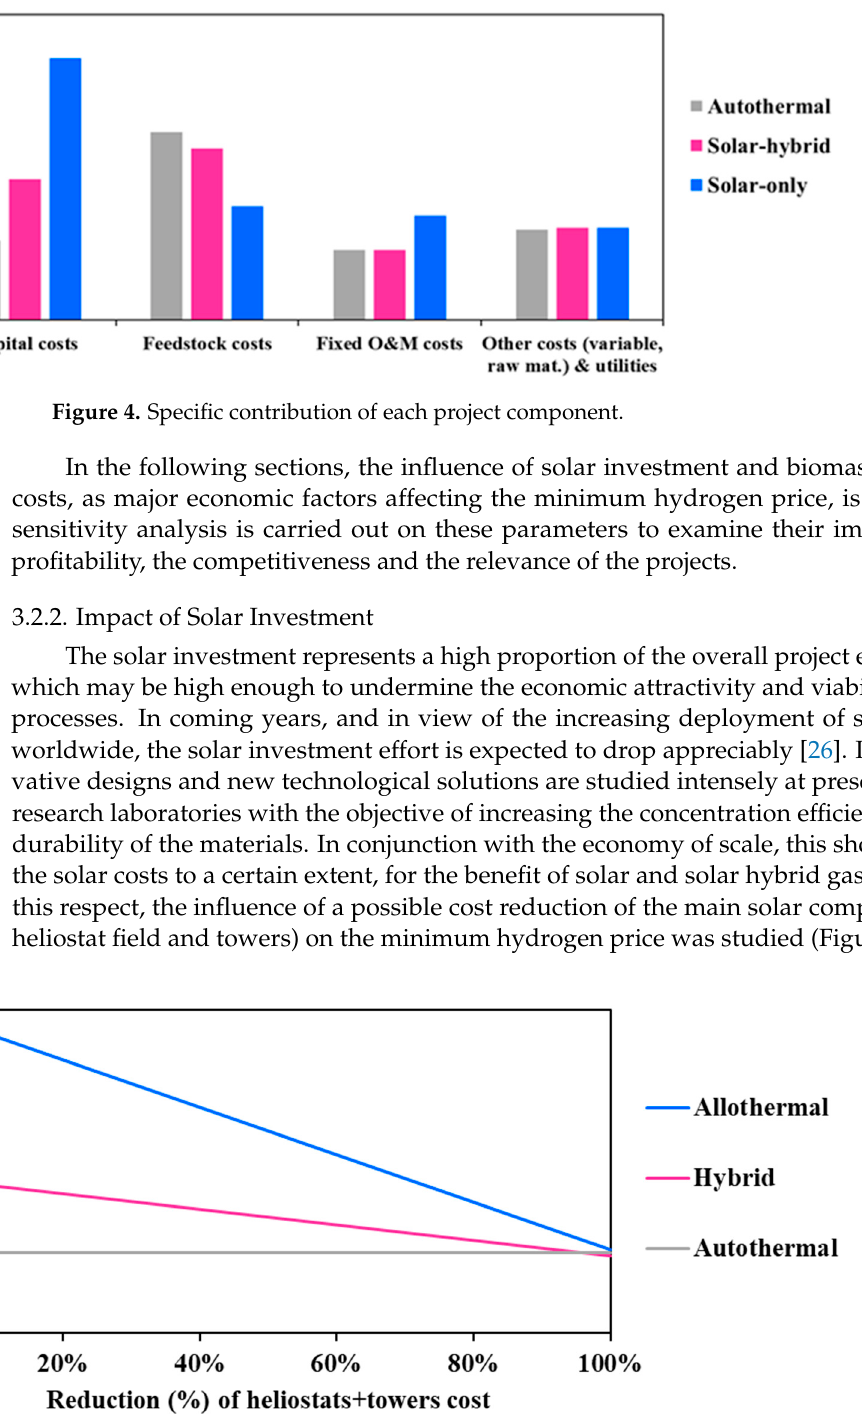
Figure 5. Impact of solar technologies cost reduction on the hydrogen minimum price.